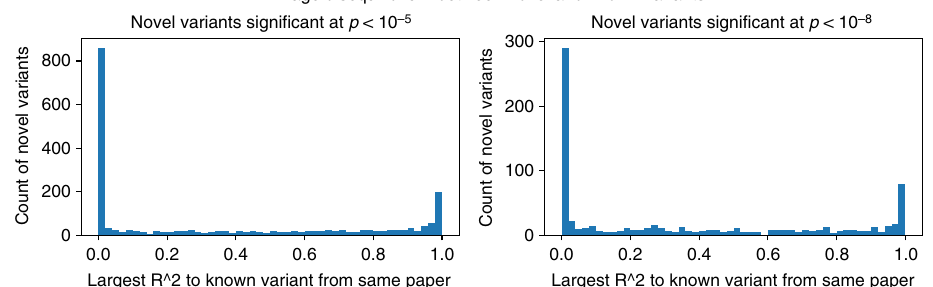
Fig. 3 Linkage disequilibrium between GWASkb variants not present in existing human curated databases and variants from the GWAS Catalog. We use the 1000 Genomes dataset to estimate the r 2 metric between pairs of variants, and report distances from each GWASkb variant to the most correlated GWAS Catalog SNP reported in the same paper. The distribution of r 2 scores is highly multimodal; many GWASkb variants are uncorrelated ( r 2 = 0) with GWAS Catalog SNPs. Reported p values are generated from χ